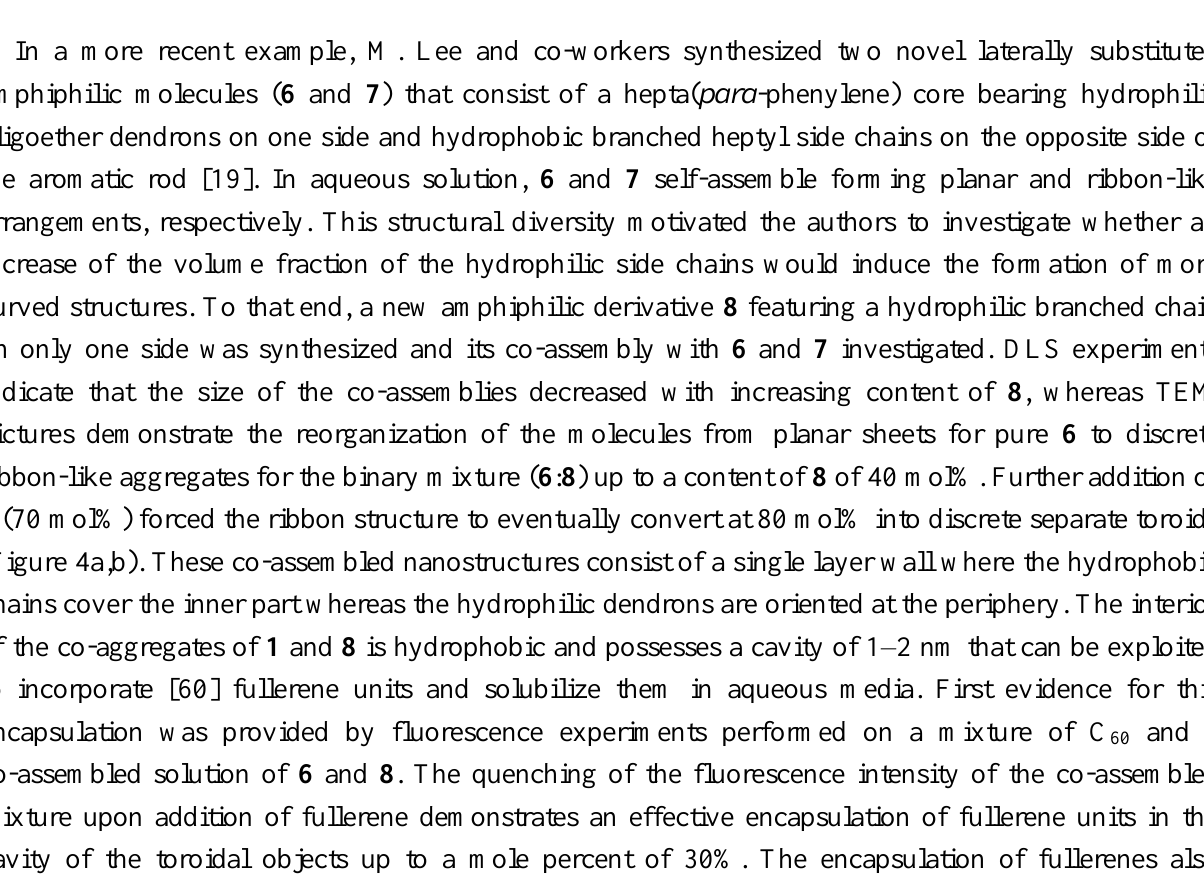
vs. q 2 for spherical app